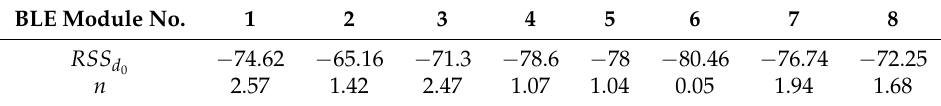
Table 14. The propagation model parameters in the case of the LoS condition. BLE Module No.